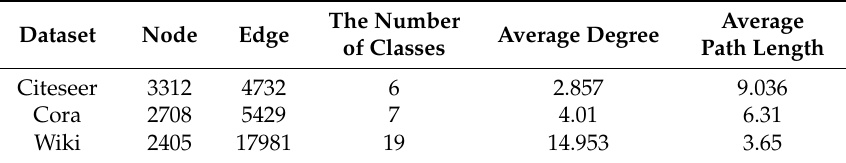
Table 1. Network datasets